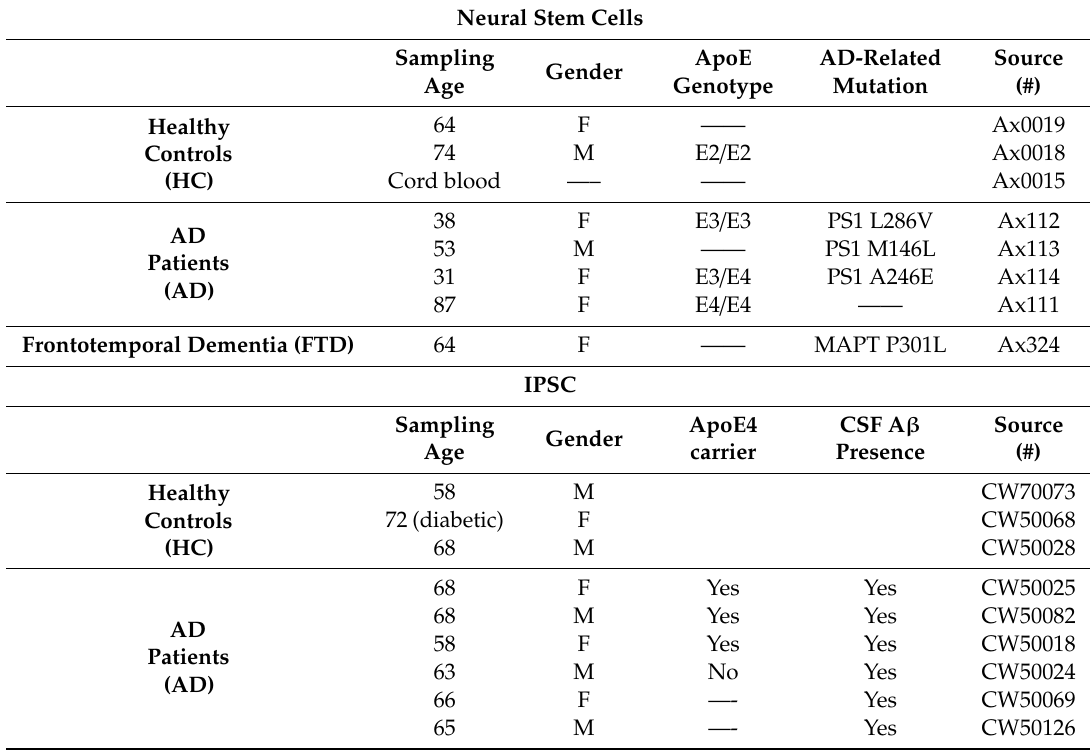
Table 1. Features of neural stem cells and induced pluripotent stem cells (IPSC) from Axol Bioscience and Coriell Institute, respectively. Age and gender are shown for each patient. ApoE genotype and the presence of AD-related mutations (presenilin 1, PS1 or microtubule associated protein tau, MAPT) in donors were included when available. A β levels in cerebrospinal fluid from AD patients from Coriell Institute were reported according to information that is available on the website. Neural Stem